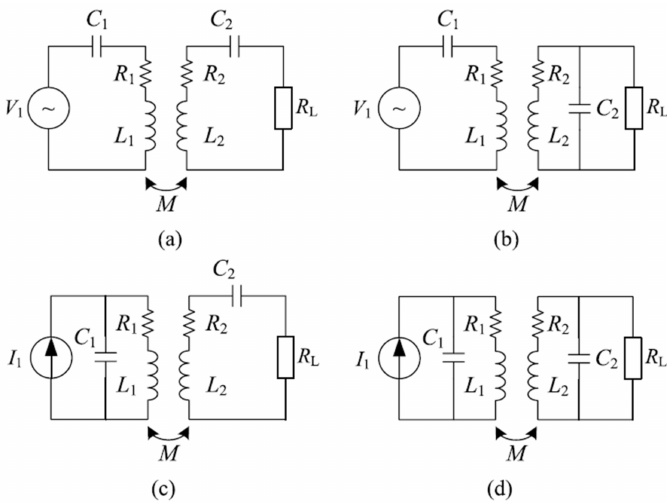
Figure 4. Four basic compensation topologies. ( a ) SS. ( b ) SP. ( c ) PS. ( d ) PP